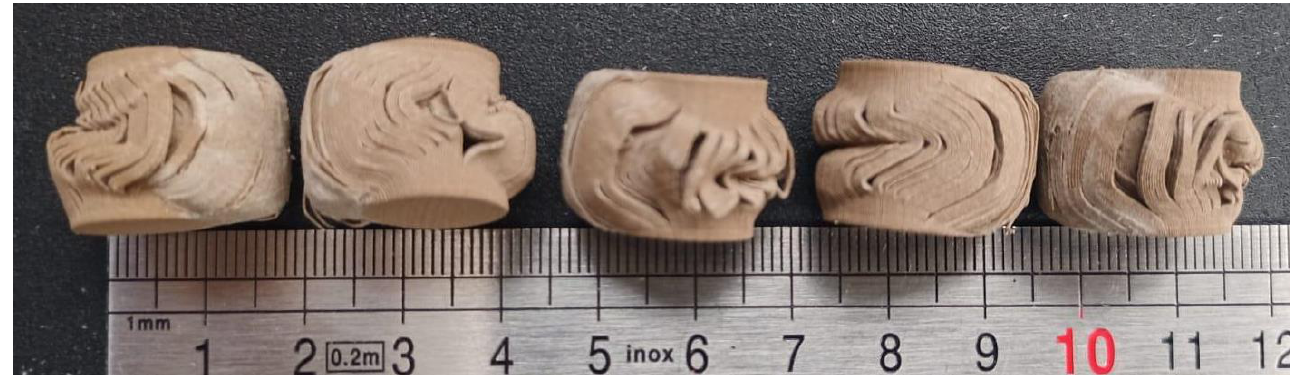
Figure 6. Horizontally layered printed samples after compression load.